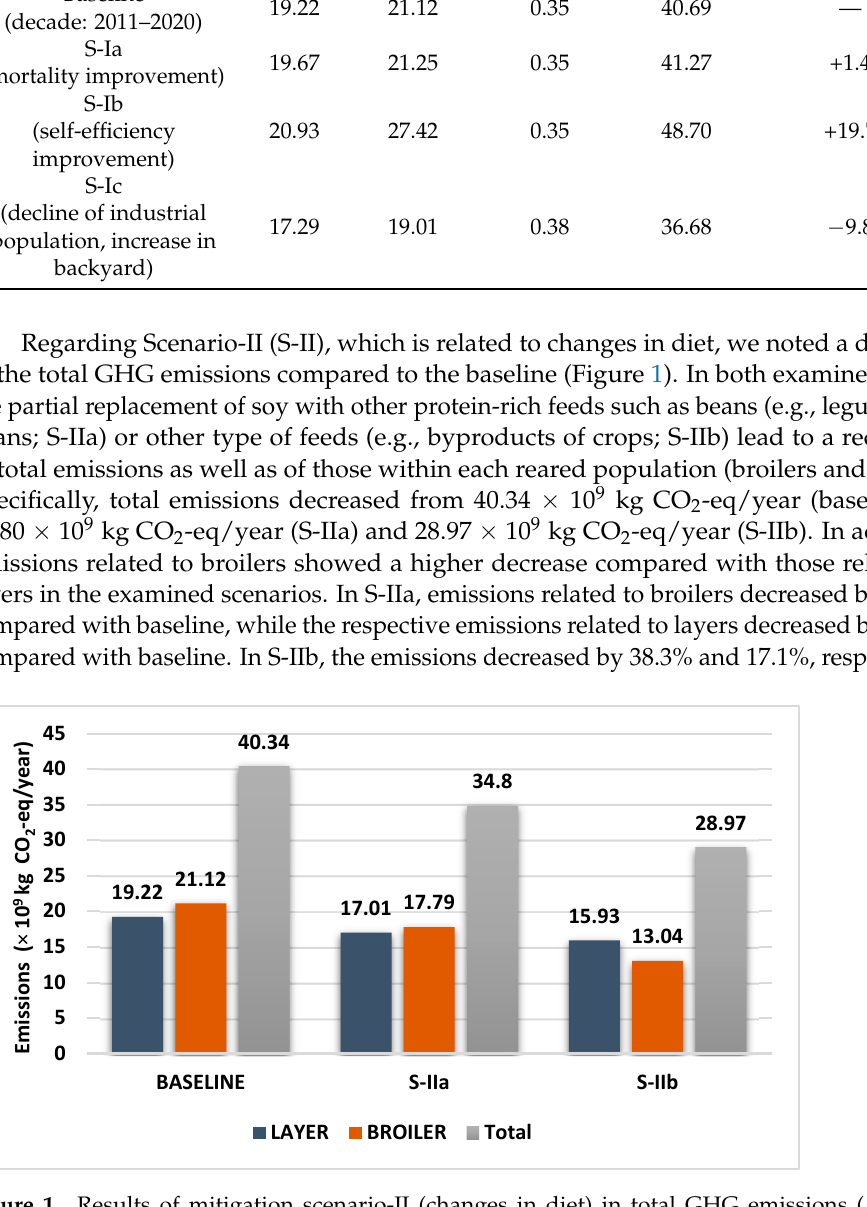
Figure 1. Results of mitigation scenario-II (changes in diet) in total GHG emissions (×10 9 kg CO 2 -eq/year) at the national level.